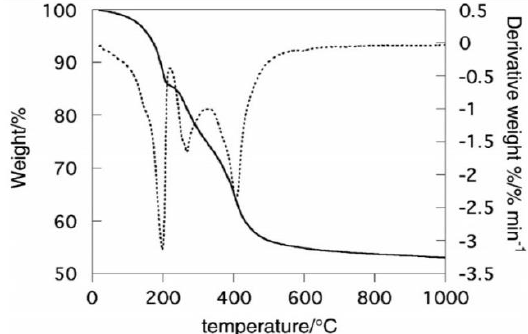
Figure 5. Thermogravimetric (solid line) and differential thermogravimetric (dotted line) analysis curves for a commercial MgAl LDH with intercalated carbonate “Ref. [67]” .